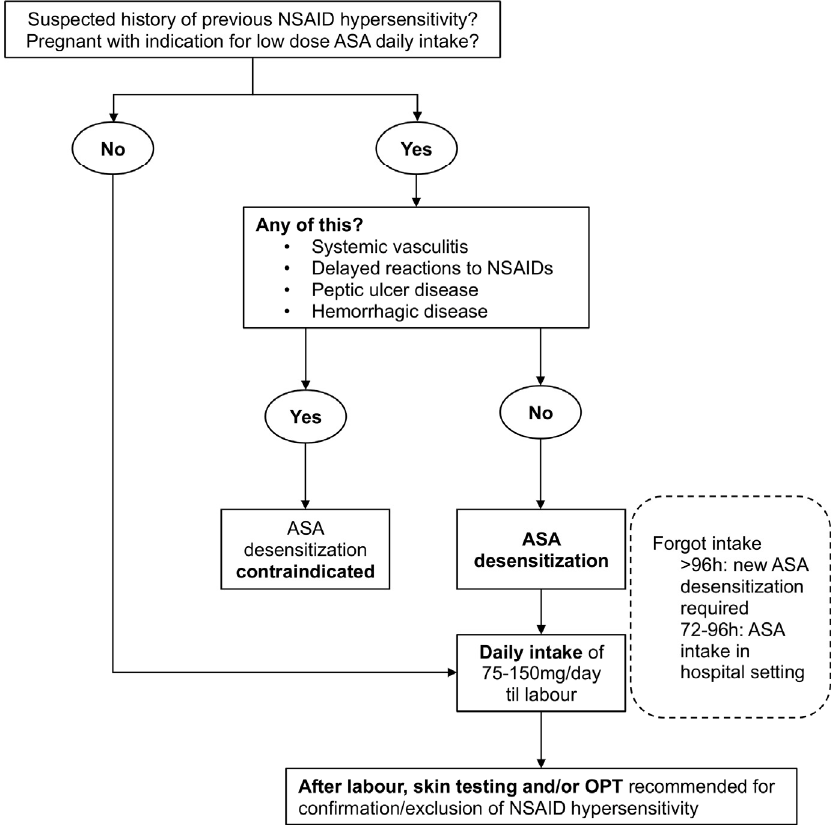
Figure 2. Therapeutic approach for ASA-sensitive pregnant women who have an indication for prophylactic treatment with low-dose ASA. ASA—acetylsalicylic acid; NSAIDs—nonsteroidal anti-inflammatory drugs; OPT—oral provocation test.